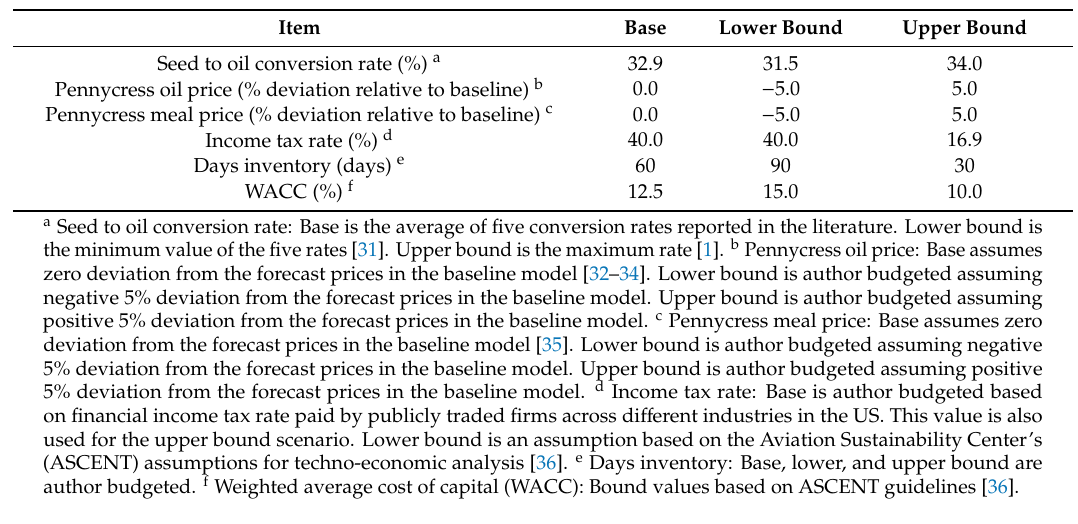
Table 2. Data and assumptions for the breakeven and one-way sensitivity analysis of maximum pennycress purchase prices for the crushing facility to obtain net present value (NPV) =